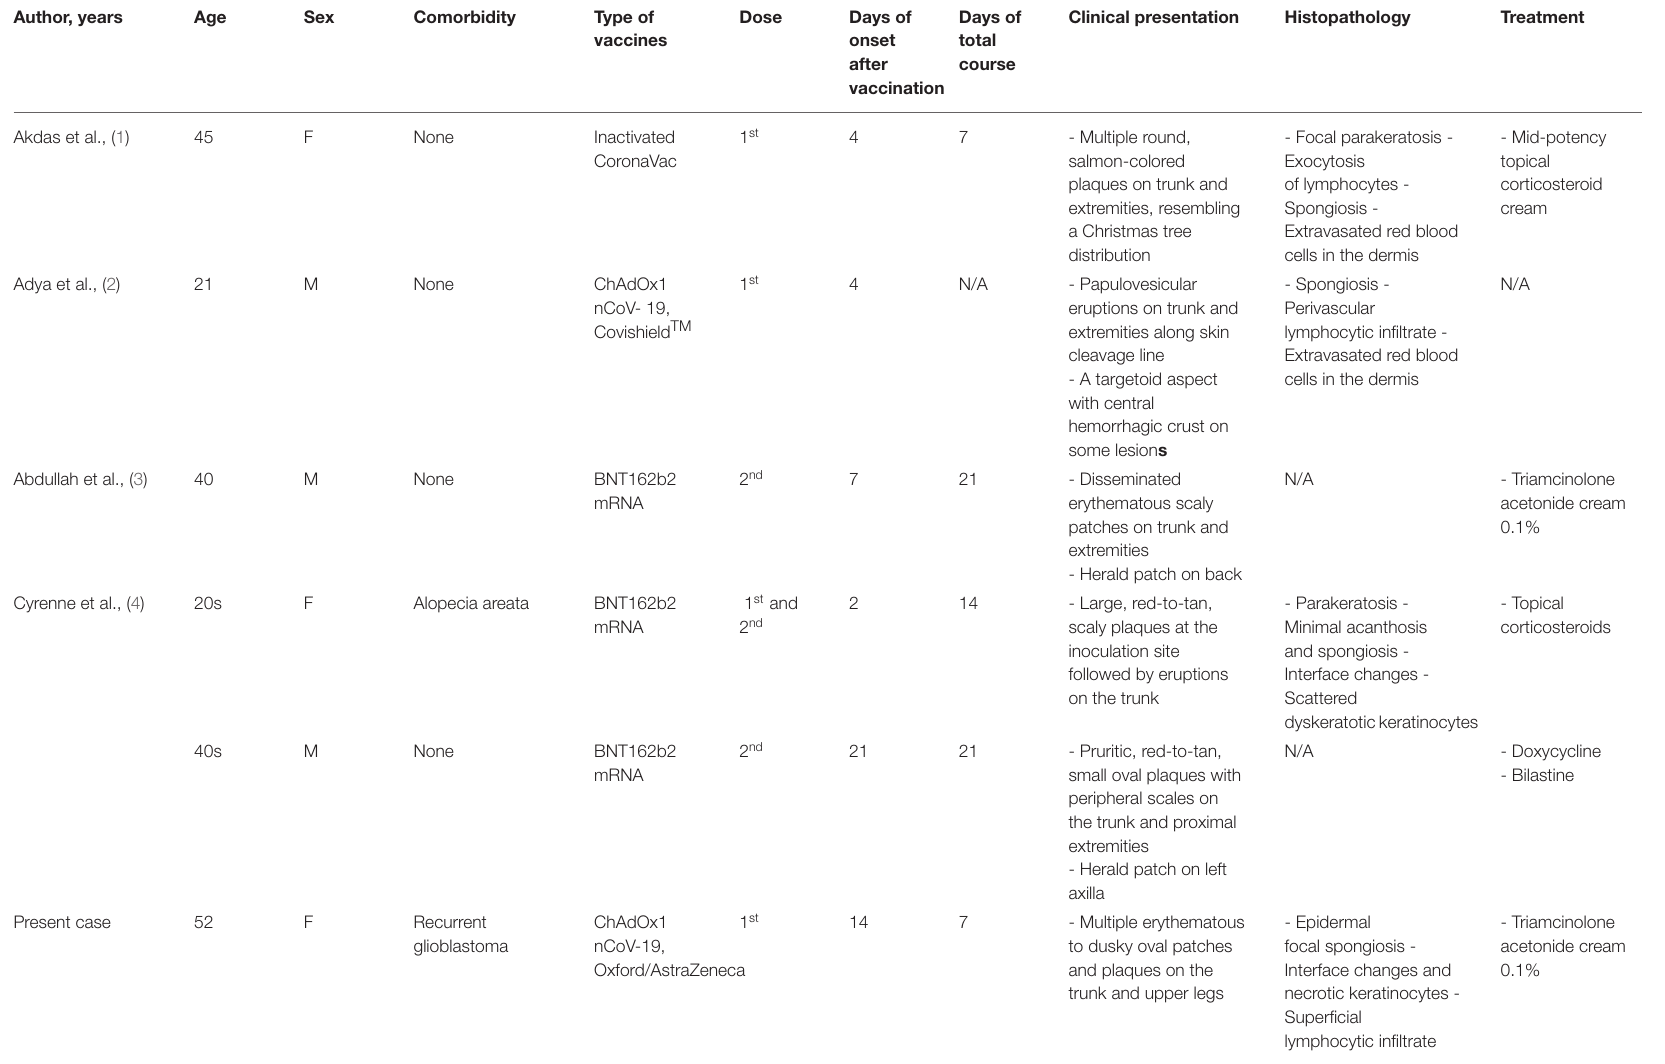
TABLE 1 | Clinical manifestations and histopathologic findings of reported patients with pityriasis-rosea like eruptions following COVID-19